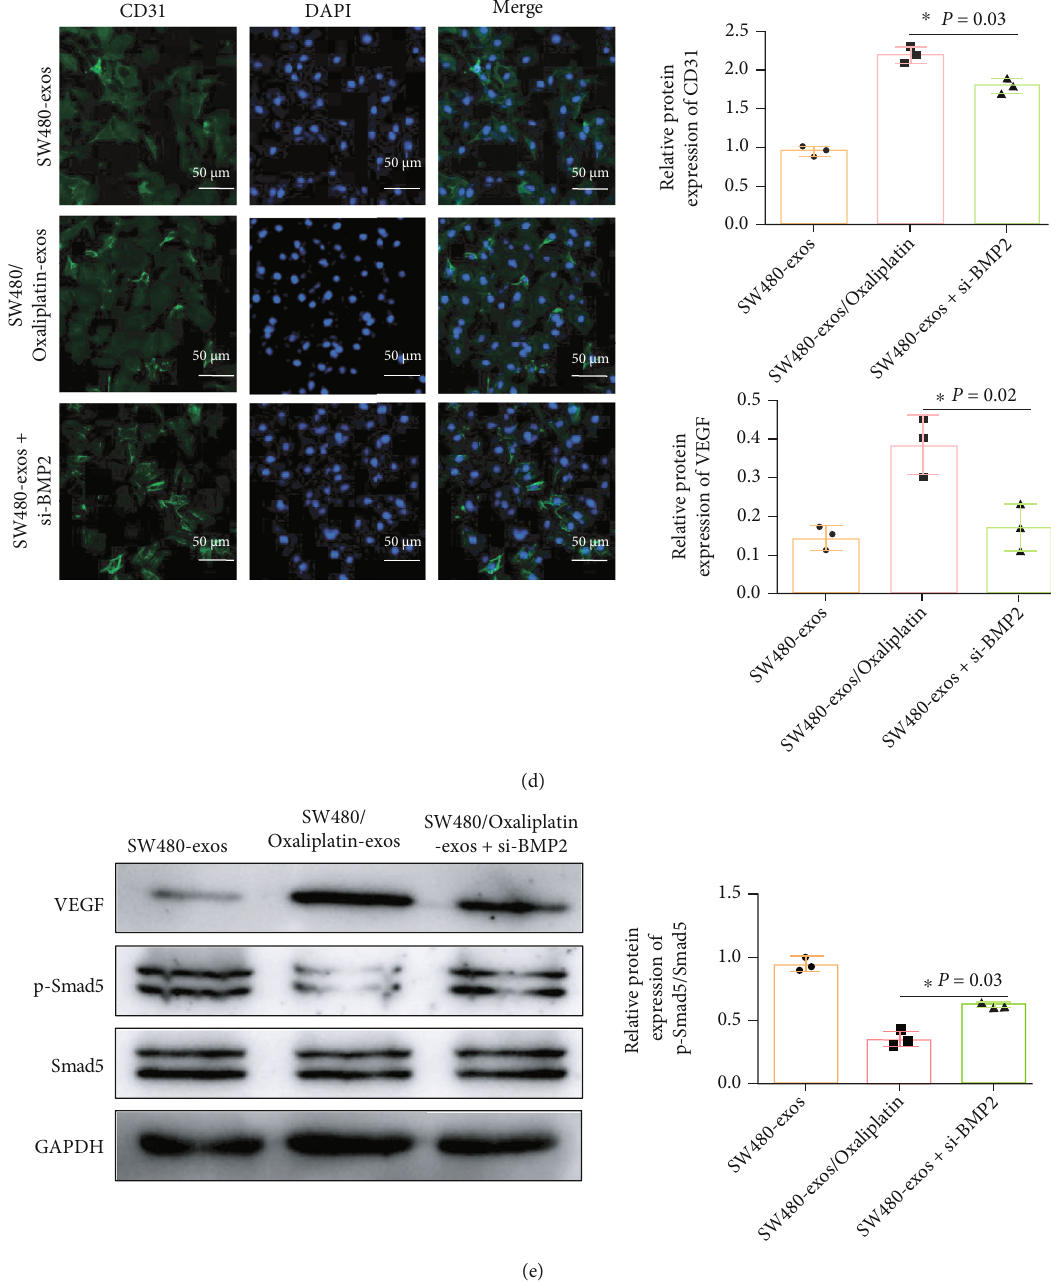
Figure 5: SW480/oxaliplatin exosomes are enriched in BMP-2, which improve angiogenesis via the inhibition of the Smad signaling pathway. HUVECs were co-cultured with SW480/oxaliplatin exosomes (40 μ g/mL) with or without the treatment of si-RNA. (a) The expression of BMP-2 in exosomes. (b) Proliferation assay of HUVECs. (c) The Transwell assay determined the HUVECs migration. (d) The expression of CD31 detected by immuno fl uorescence. (e) The protein expression of VEGF and phosphorylation Smad5 in HUVECs. All above experiments were repeatedly performed 3 times; data are shown as the means ± SD . ∗ P < 0 : 05 , ∗∗ P < 0 : 01